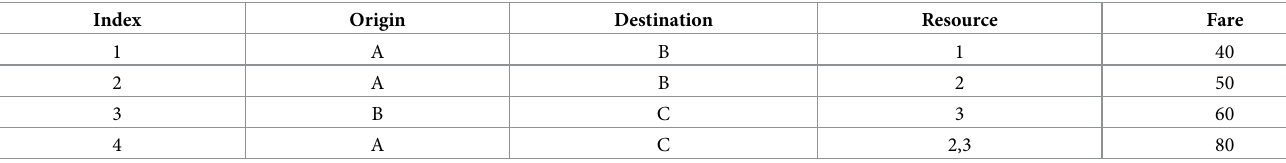
Table 3. List of products in the example network.